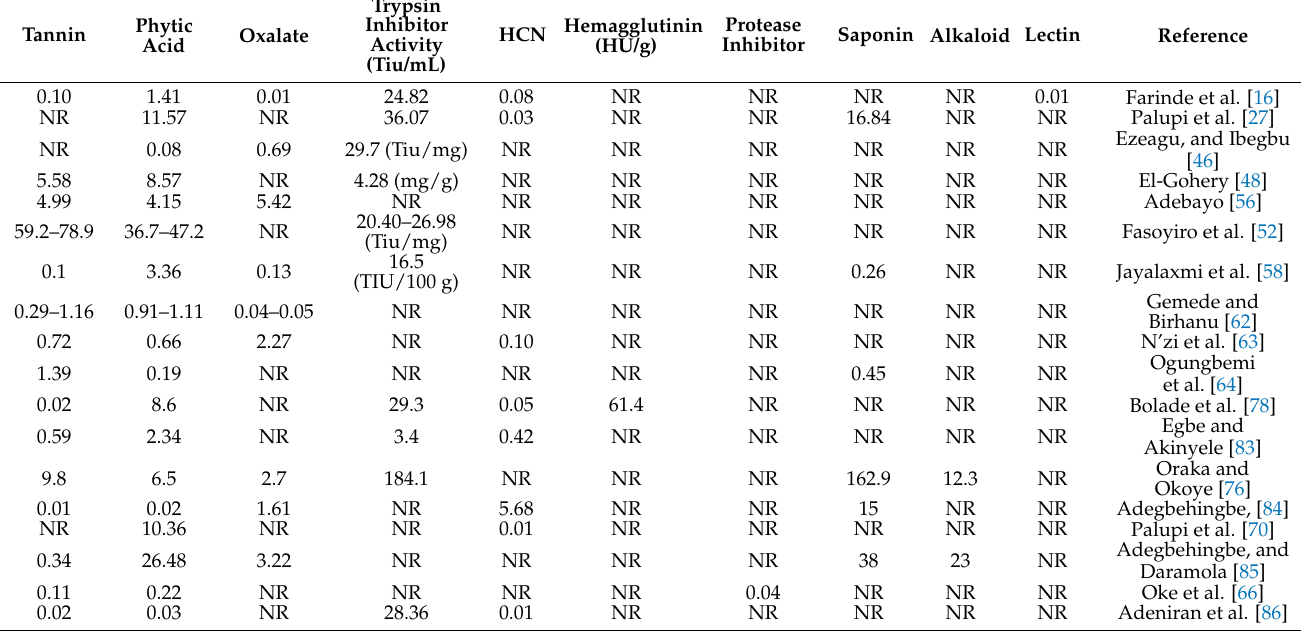
Table 4. Anti-nutritional factors (mg/g) of lima beans reported in